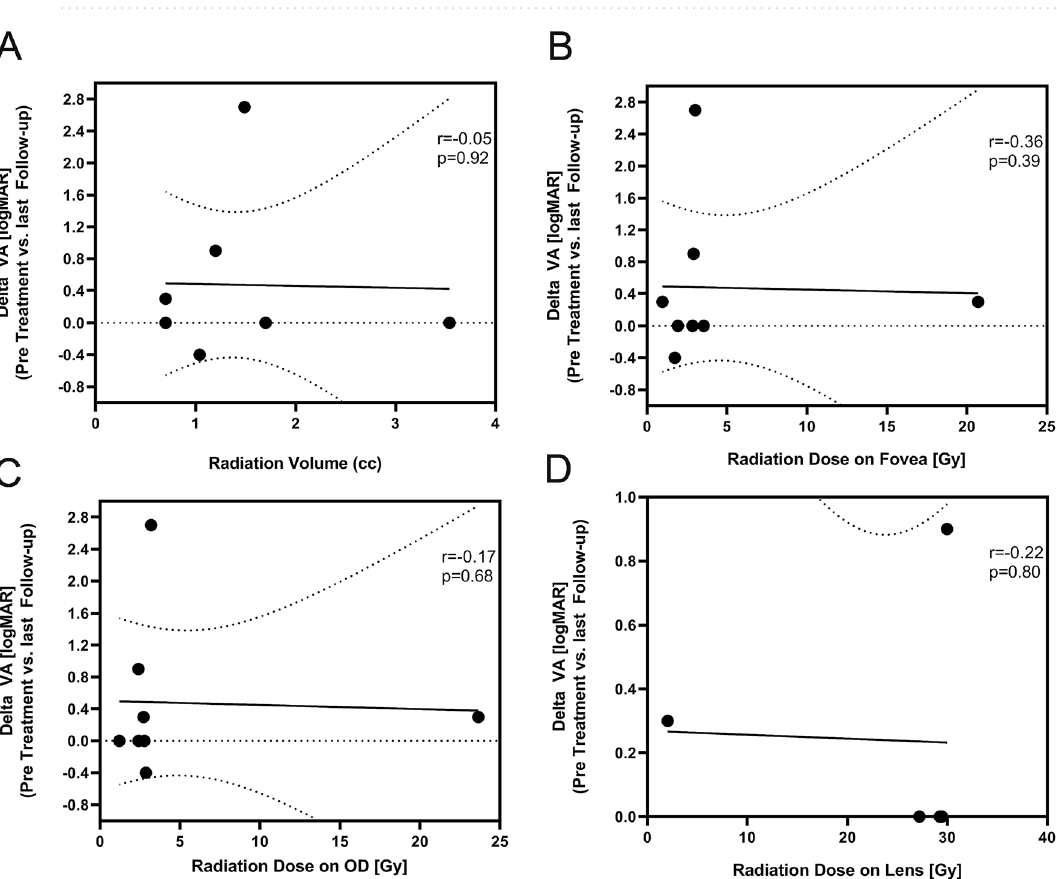
Figure 3. There was no correlation between total radiation dose, radiation dose on optic disc, fovea or lens with the degree of change in visual